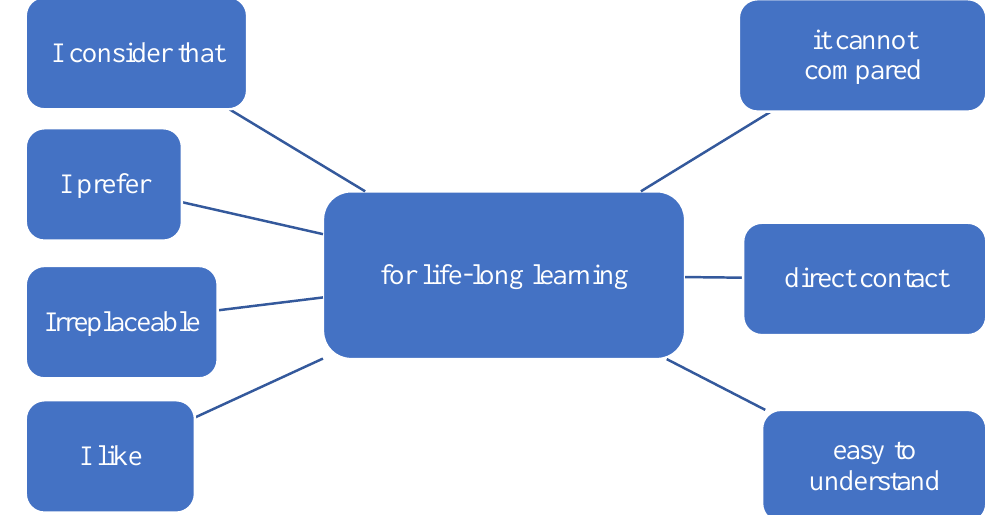
Figure 4. Reasons in favor of the physical school environment.